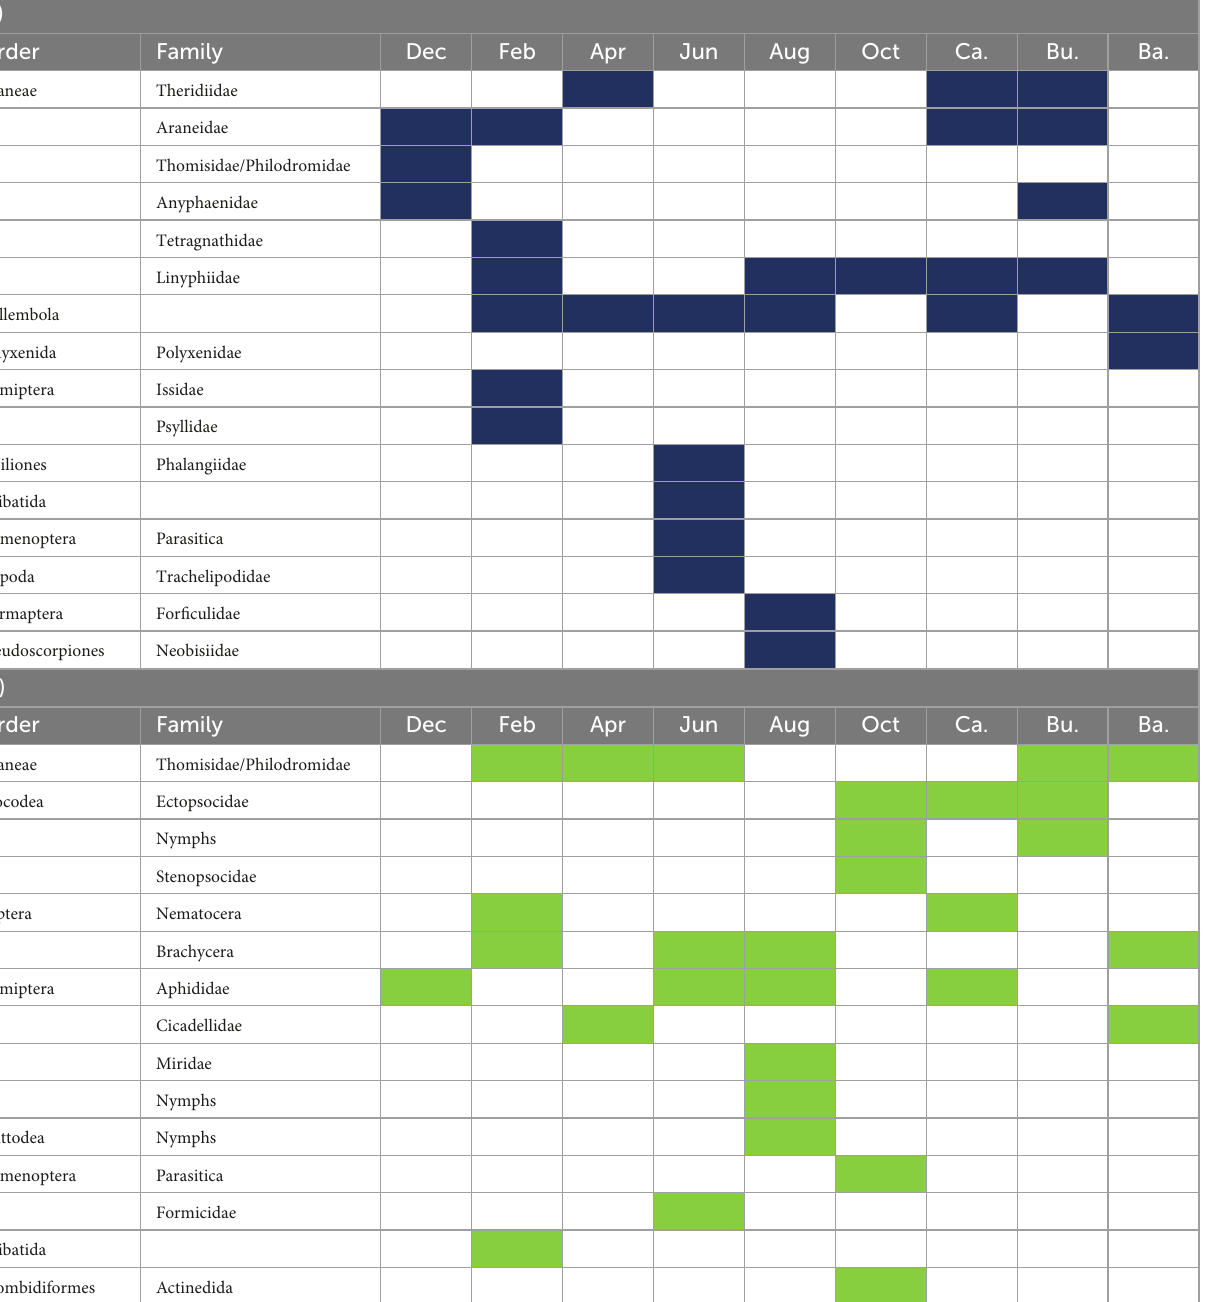
TABLE 4 Main taxonomic groups explaining variations in arthropod community composition along the rural-urban